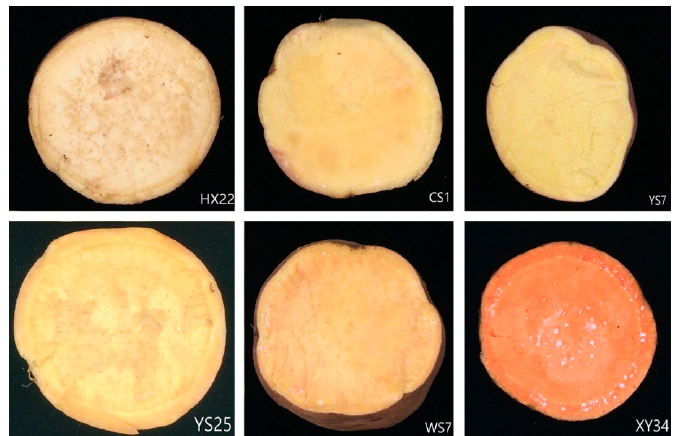
Figure 1. The six varieties of sweet potato roots.